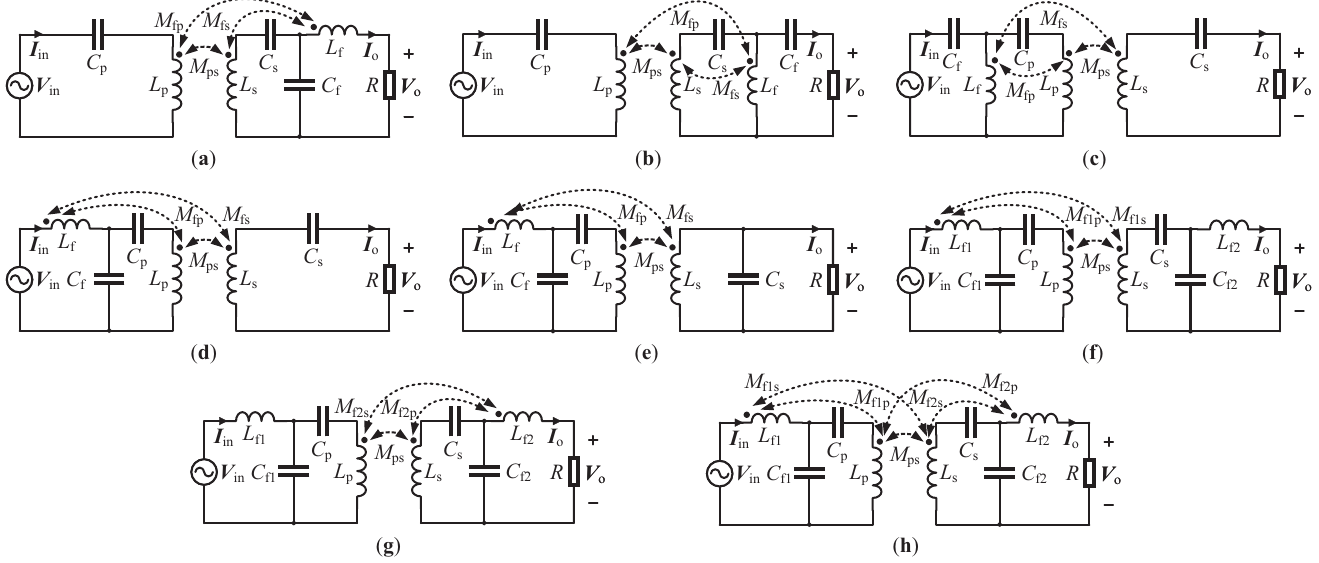
Figure 2. Conventional high-order network topologies for WPT considering extra couplings brought by the compensation inductors. ( a ) S- LCC topology. ( b ) S- CLC topology. ( c ) CLC -S topology. ( d ) LCC - S topology. ( e ) LCC -P topology. ( f ) Primary-side-integrated LCC - LCC topology. ( g ) Secondary-side- integrated LCC - LCC topology. ( h ) Double-side-integrated LCC - LCC